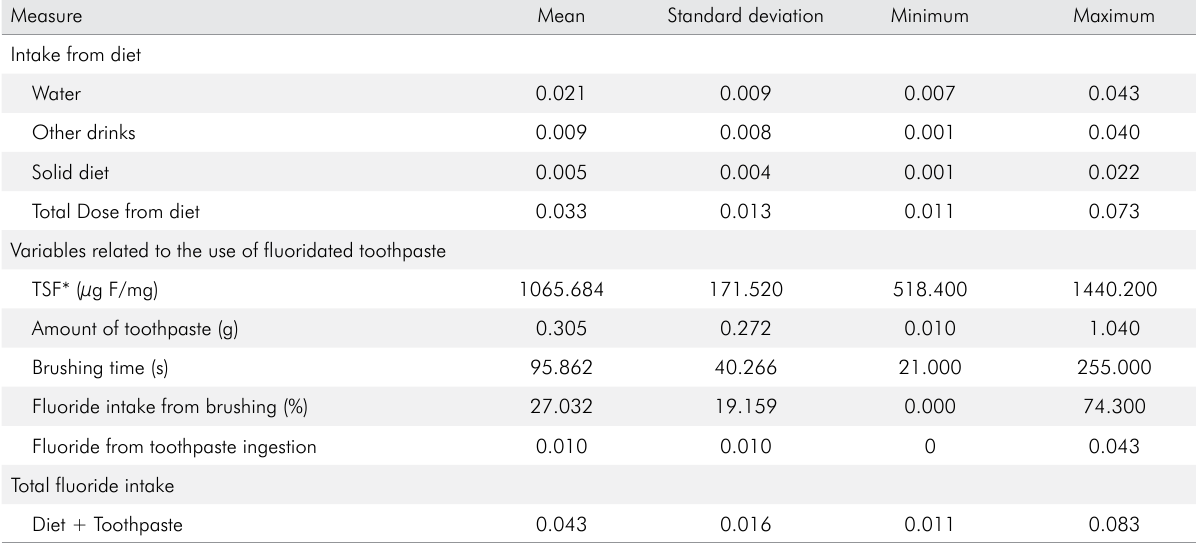
Table 1. Contribution of each source of fluoride to total fluoride intake (mg F×kg -1 ×d -1 ) for children from diet and fluoride toothpaste.